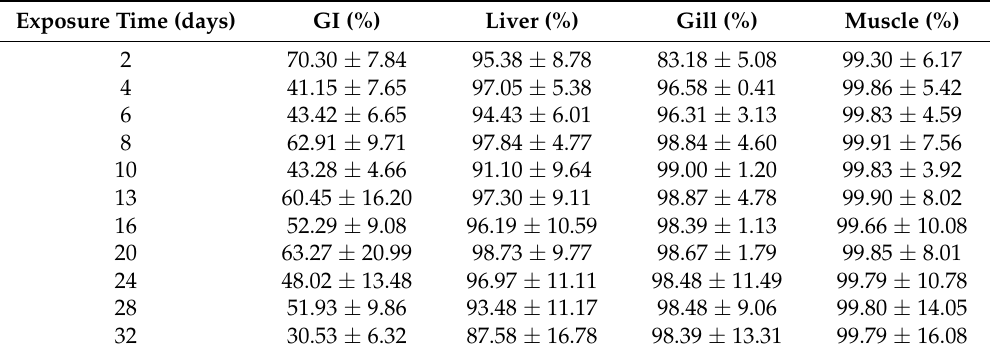
Table 1. The percentage of organic arsenic in different tissues for As(III) exposure.